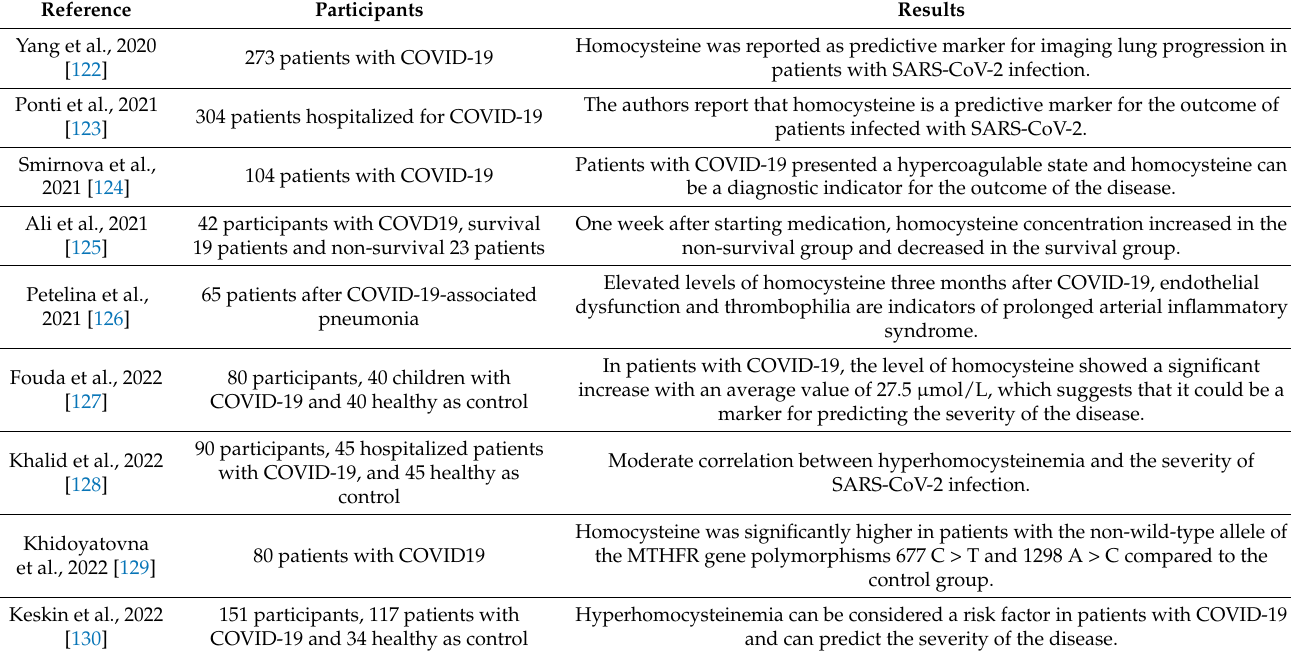
Table 2. Studies indicating a correlation between HCY levels and COVID-19